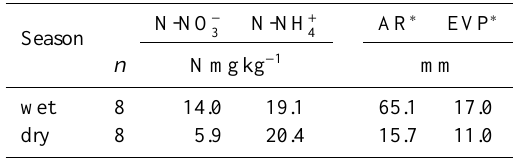
Table 2. Mineral nitrogen content (N-NO − lated rainfall (AR) and potential evapotranspiration (EVP) during dry and wet